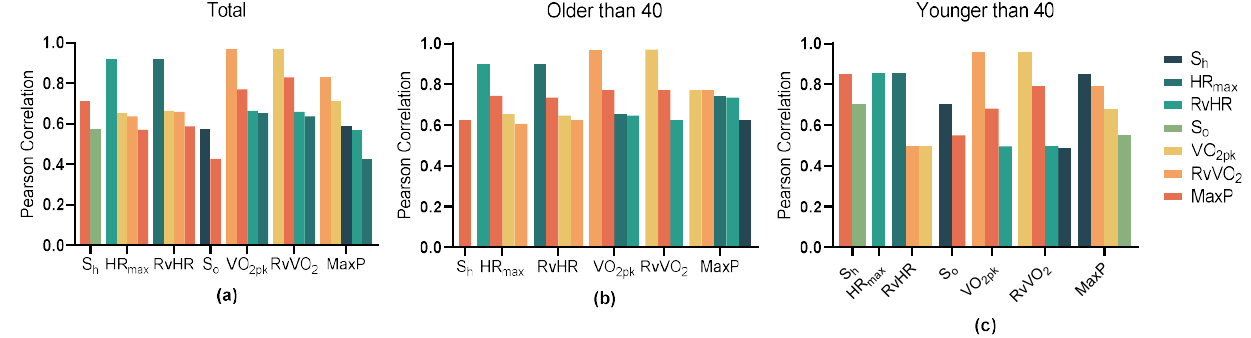
Figure 5. Details of the relationship between all types of data in exercise data with the significant relationships ( p < 0.001) and divided into three sets based on age. ( a ) Total; ( b ) Older than 40; ( c ) Younger than 40.